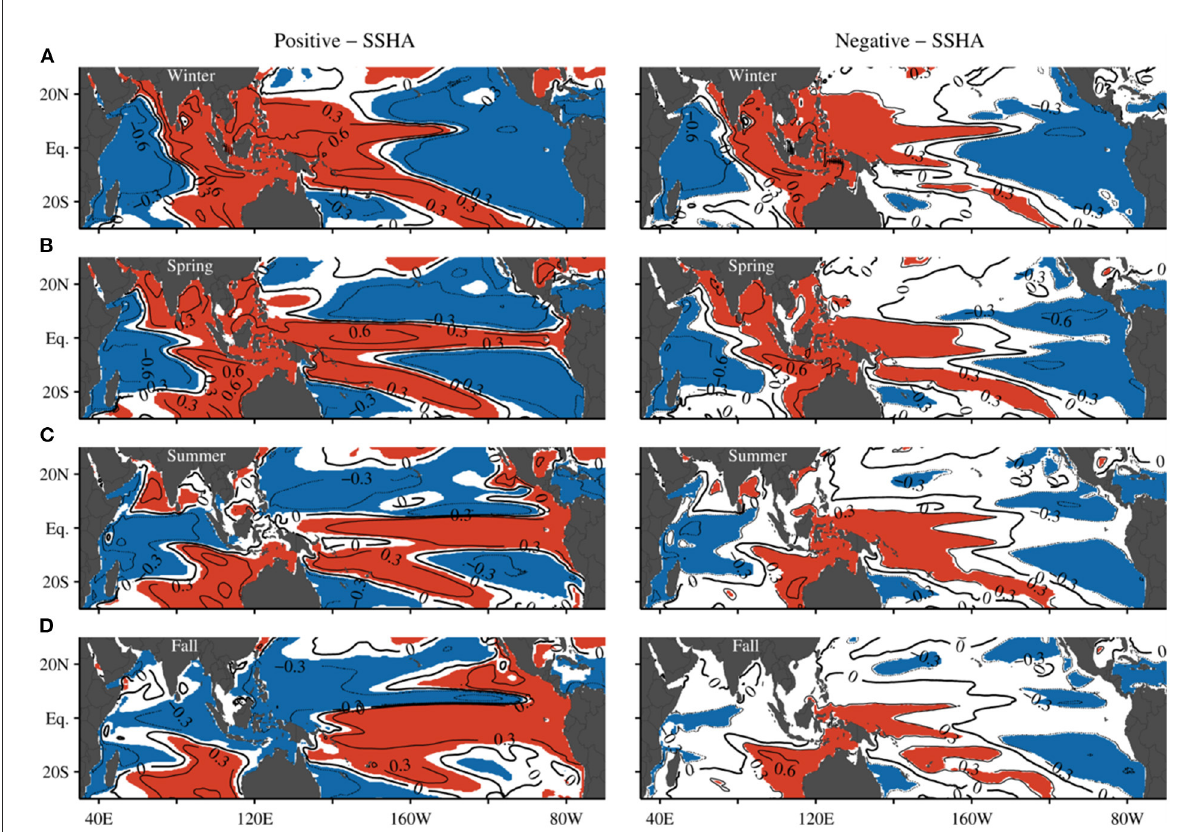
FIGURE12 Comparison of lag correlations between the SSHA in STIO in fall and the tropical Indo-Pacific SSHA in the following four seasons during the positive (left column) and negative (right column) phases of the decadal variability in the CCSM4 historical simulations. (A) Winter (December to February). (B) Spring (March to May). (C) Summer (June to August). (D) Autumn (September to November). The contour interval is 0.3. Dark and light shades indicate 99% confidence level of positive and negative correlation,